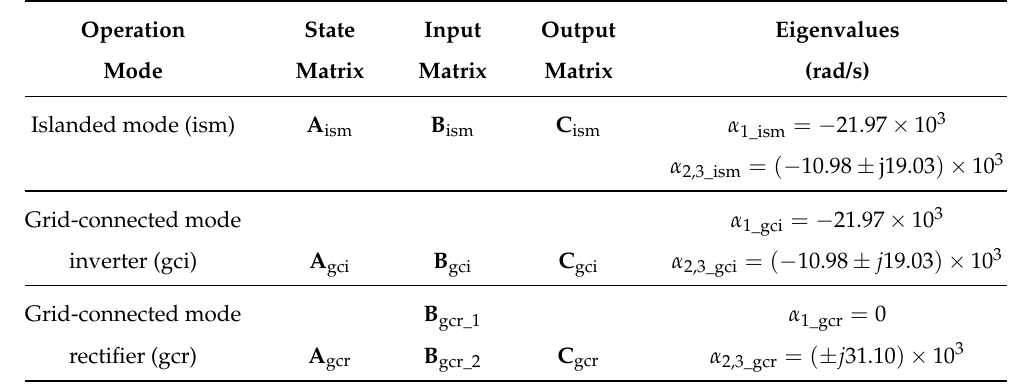
Table 2. Open-loop matrices and eigenvalues.